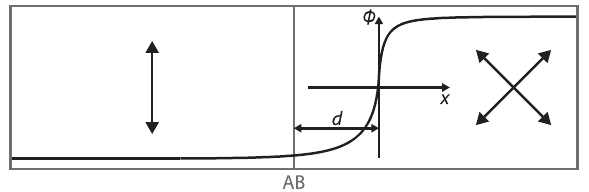
FIG. 7. The domain-wall pinning potential V ð d Þ of an anisotropy boundary (AB) between domains with uniaxial and cubic magnetic anisotropy can be estimated by calculating the increase of anisotropy energy when the magnetic domain wall [ ϕ ð x Þ ] is moved to position d . The anisotropy boundary in the Fe film is created by elastic coupling to an underlying ferroelectric a - c domain wall in the BaTiO 3